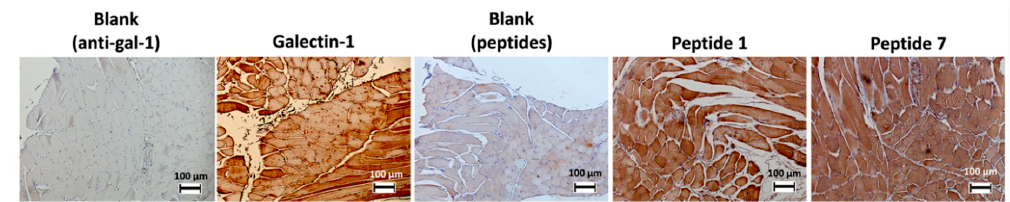
Figure 2. Immunostaining of gal-1 in infrahyoid muscles using biotinylated peptides 1 and 7 or anti-gal-1 antibody.